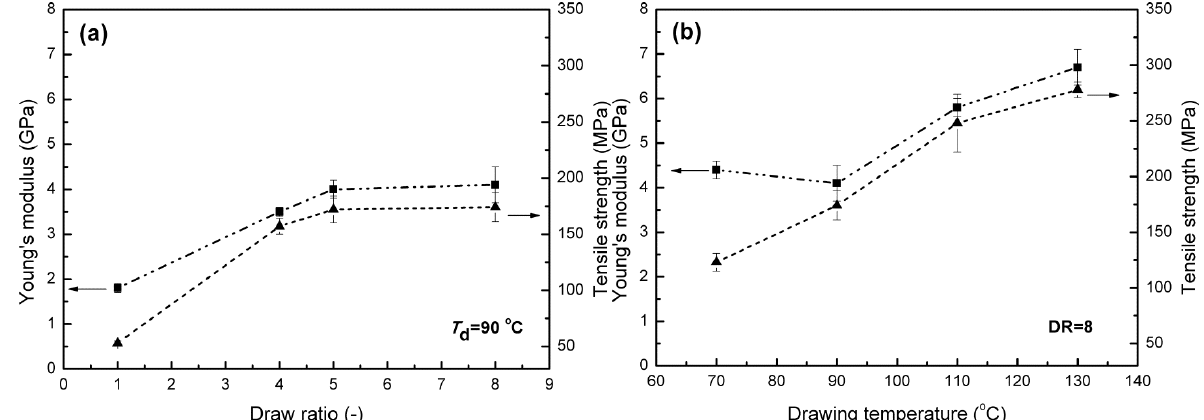
Figure 3. Young’s modulus and tensile strength as a function of ( a ) draw ratio and ( b ) drawing temperature in the specimen.